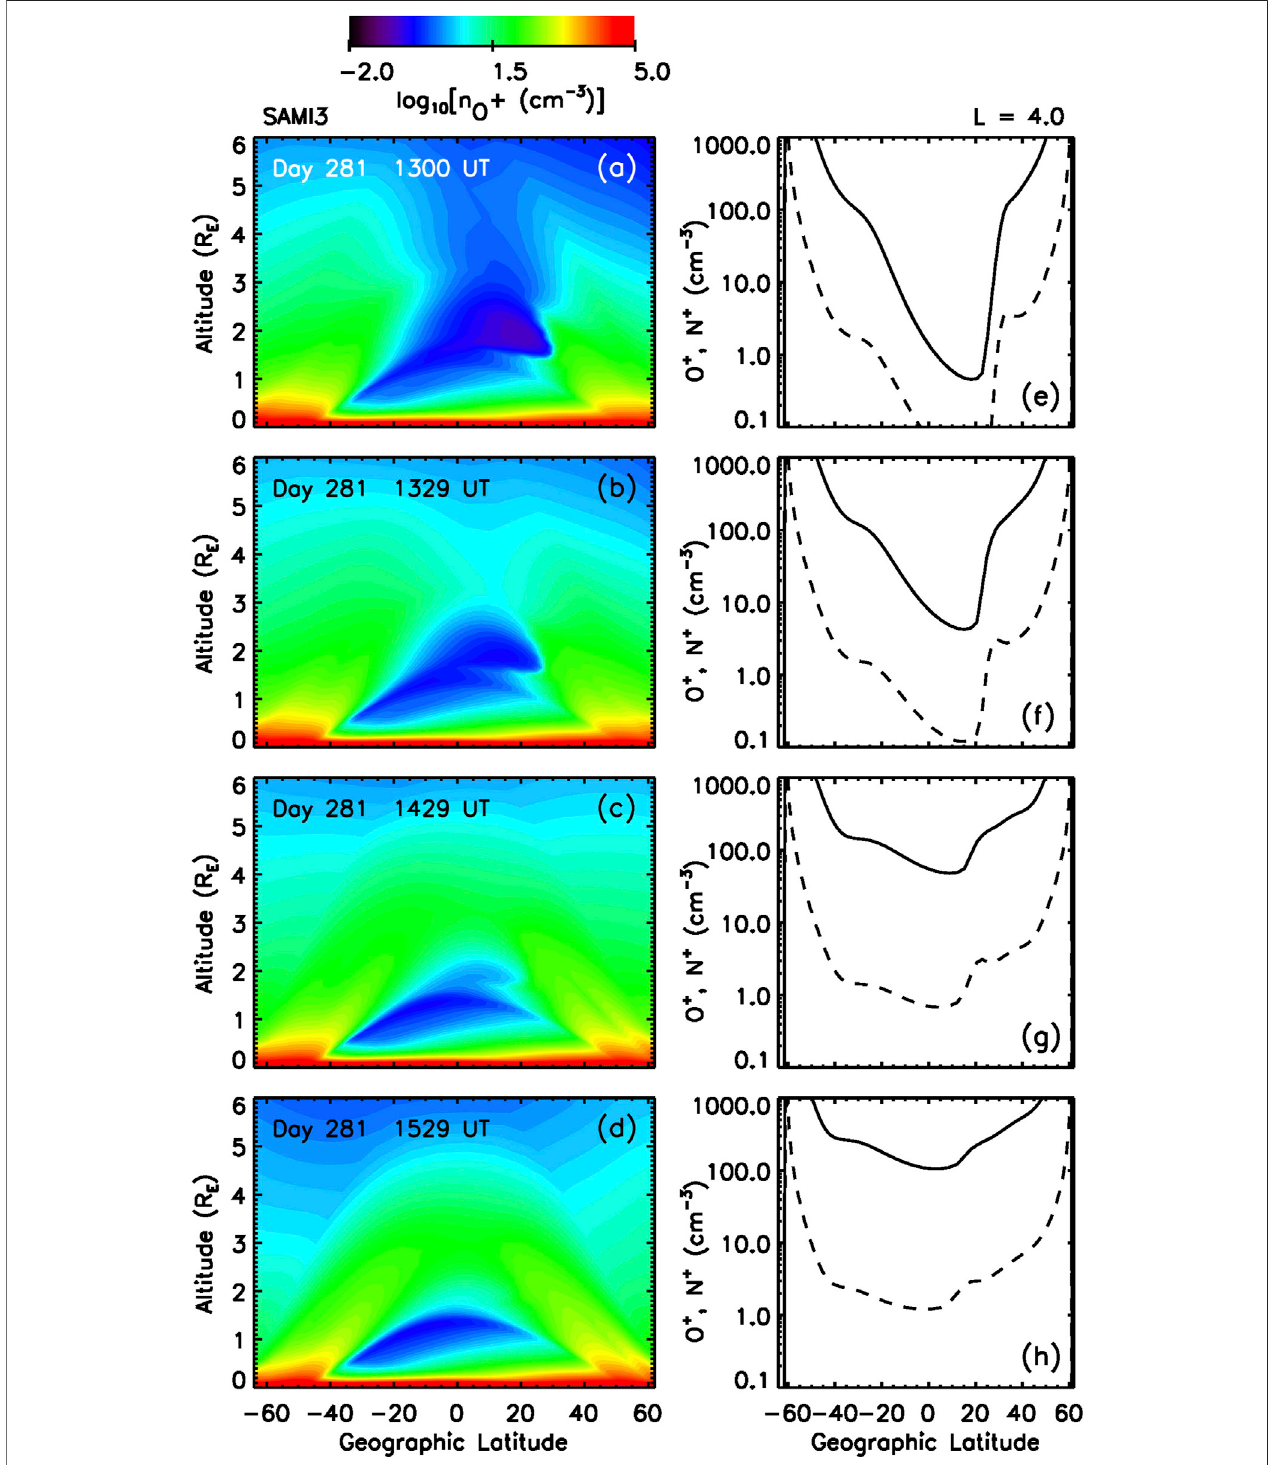
FIGURE 6 | Color contours of the log of the O + density (A – D) versus latitude and altitude and O + (solid) and N + (dashed) ion densities (E – H) versus latitude on an L (cid:2) 4 fi eld line at various times from the SAMI3 (one fl uid H + ) simulation. Panels (B,F) are at the same time as Panels 5C,D .